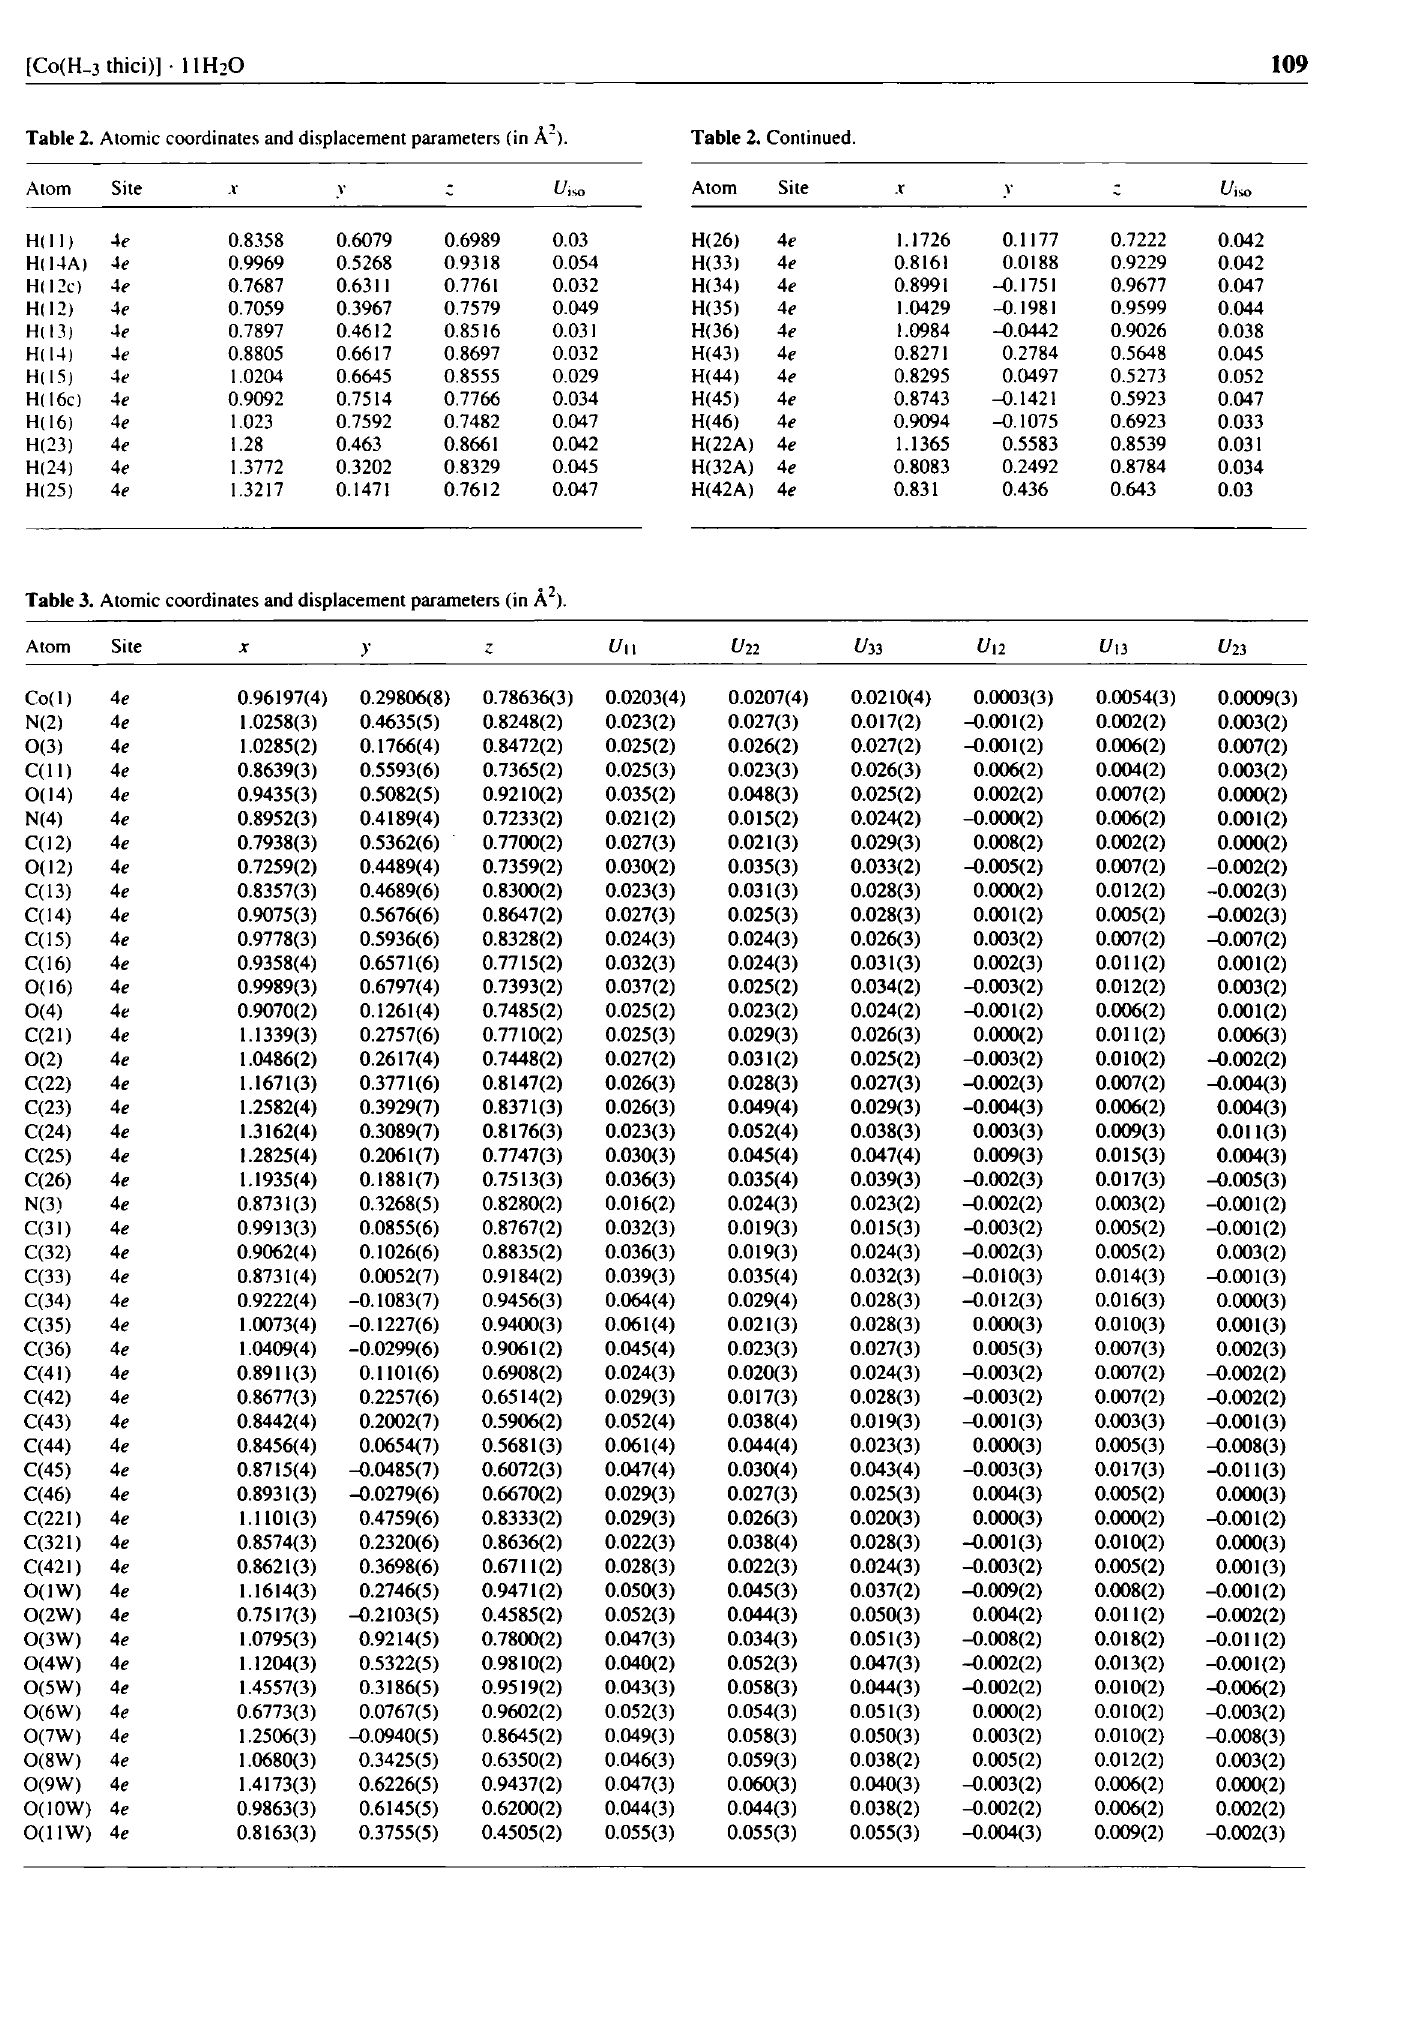
Table 3. Atomic coordinates and displacement parameters (in Ä 2